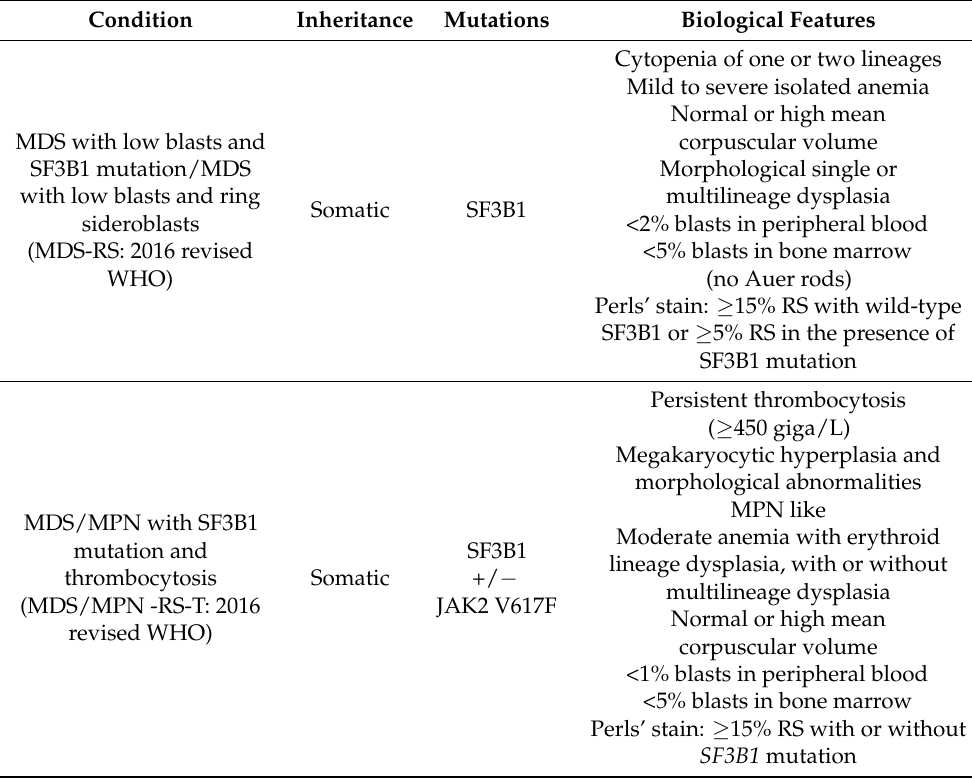
Table 1. Classification of acquired clonal sideroblastic anemias (adapted from 2022 revised WHO